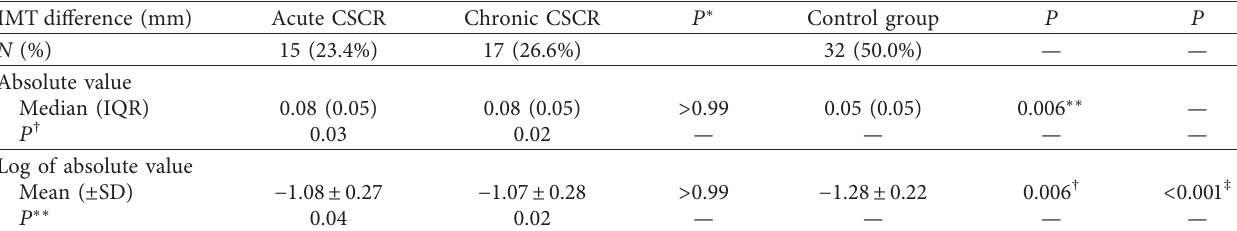
Figure 1: Means and 95% confidence intervals (CI) for IMT (mm) in participants with acute and chronic CSCR and control by measurement. Table 3: Absolute value of the difference of IMT between the two sides and its logarithm in participants with acute and chronic CSCR and control